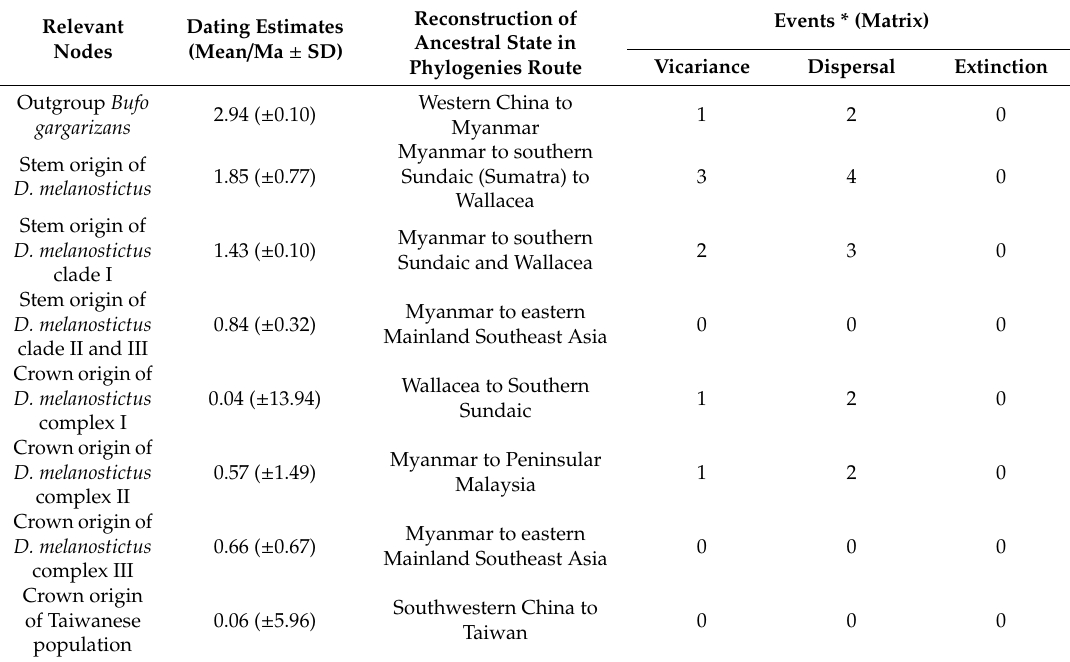
Table 1. Summary of dating estimates, statistical dispersal-vicariance analysis and Bayesian Binary Method reconstruction analyses for Duttaphrynus melanostictus based on 303 sequences of mtDNA tRNAGly-ND3 fragments, with a highlight on relevant nodes and route of dispersion. Events * Relevant Dating Estimates Nodes (Mean / Ma ± SD) Phylogenies Route